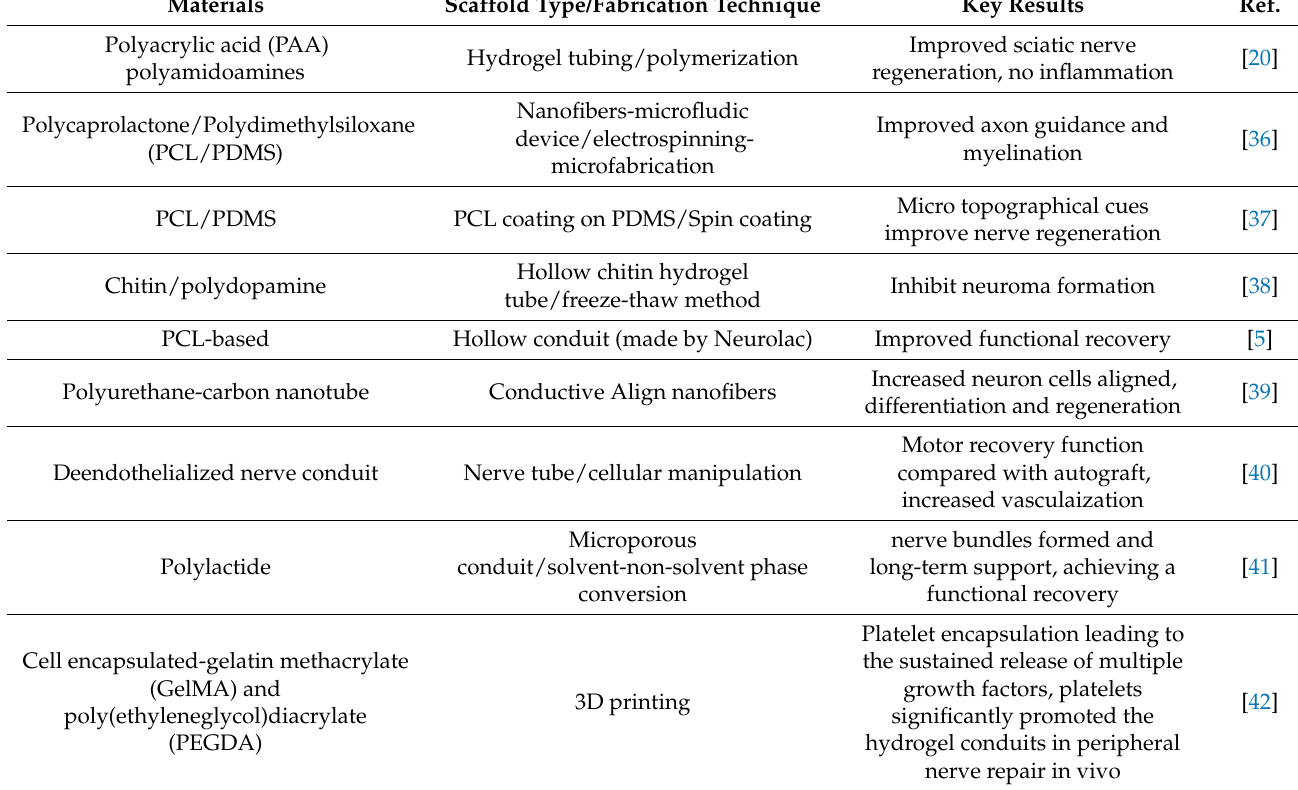
Table 1. Nerve conduits used in peripheral nerve guidance and